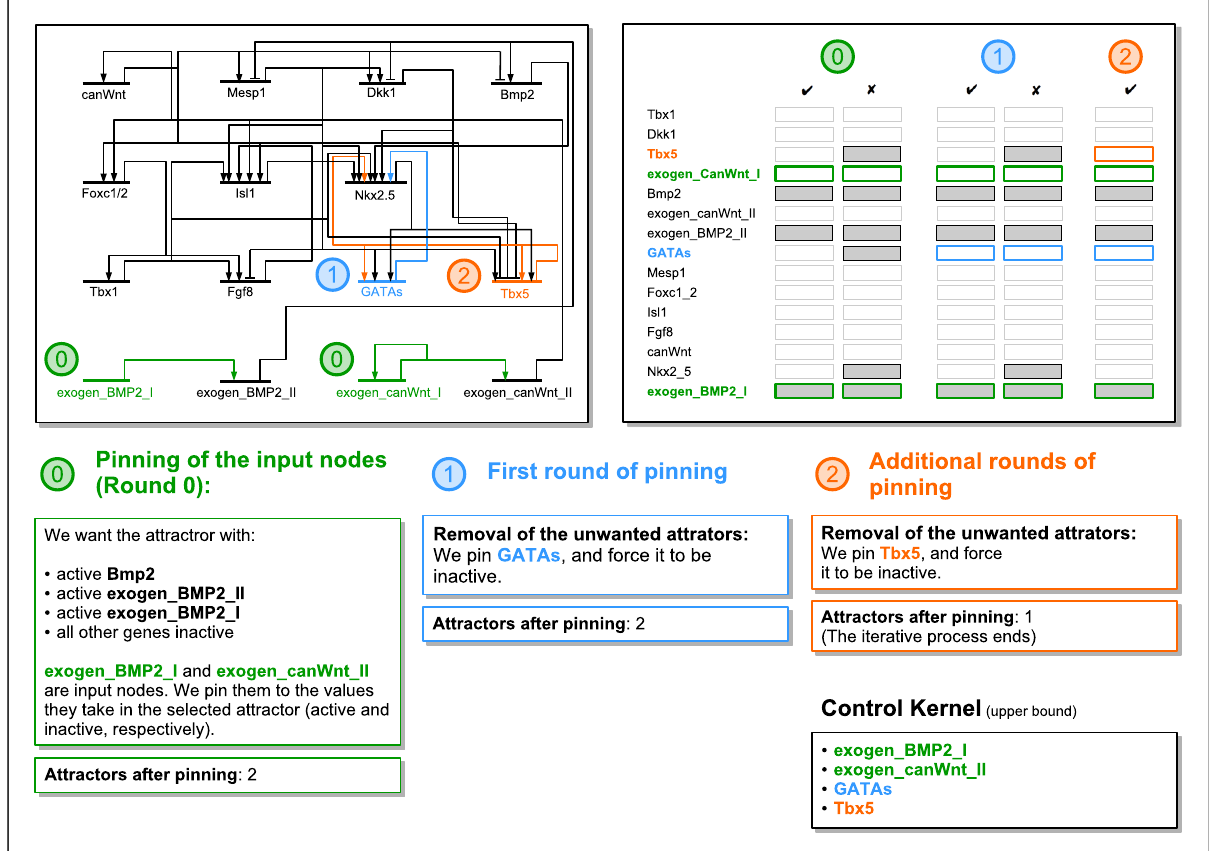
Fig. 3 Schematic of our iterative pinning procedure. This example demonstrates selecting a particular attractor in the network describing the core gene regulatory network for early cardiac development 32 . (Note that we use the iterative procedure only to put bounds on the control kernel size as in Eq. (2), while the true minimal control kernel can be computed by an exhaustive procedure as explained in the Methods. In this particular case, the two methods produce identical results.).